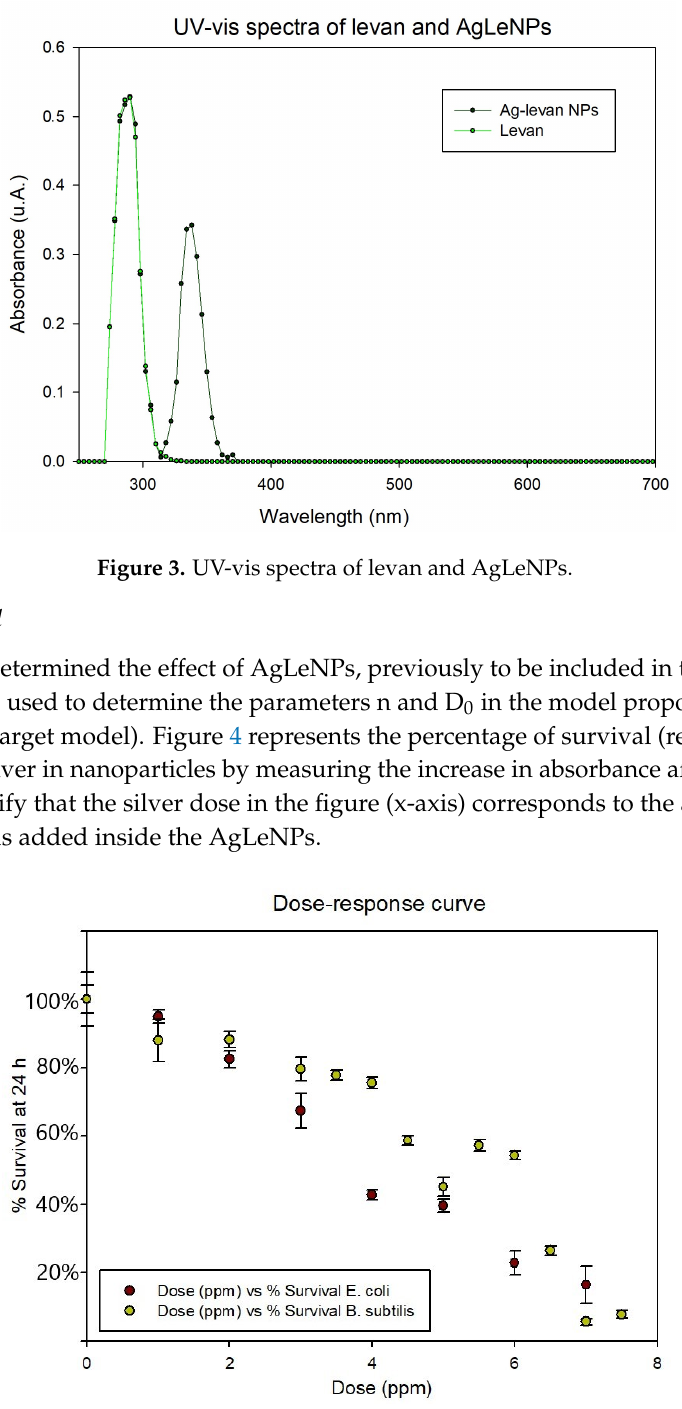
Figure 4. Dose- response curve for E. coli and B. subtilis with AgLeNps .